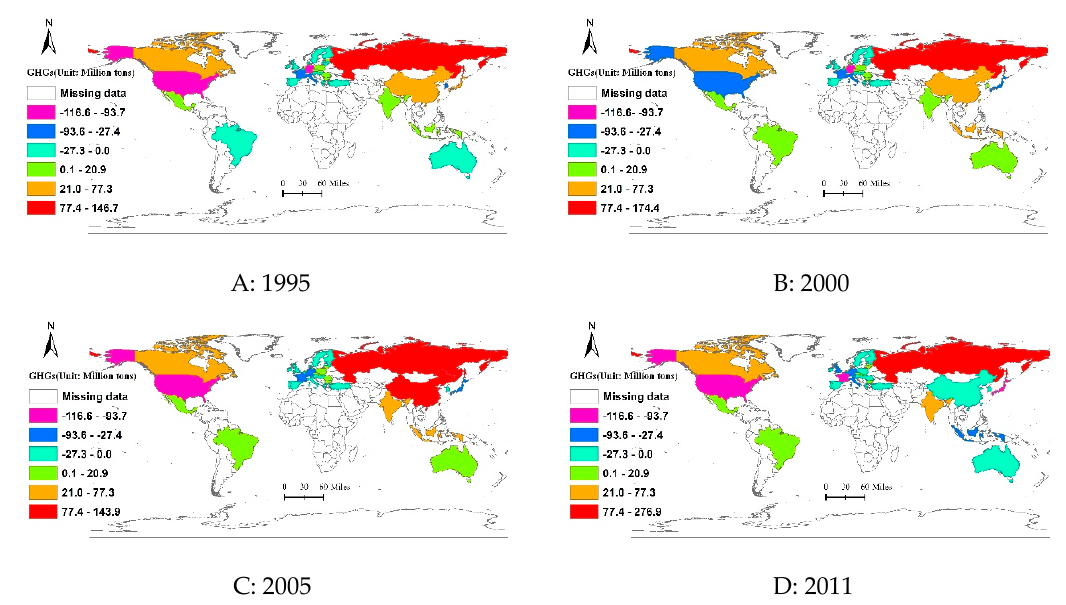
Figure 3. Spatiotemporal evolution characteristic of the net output of embodied GHGs in international